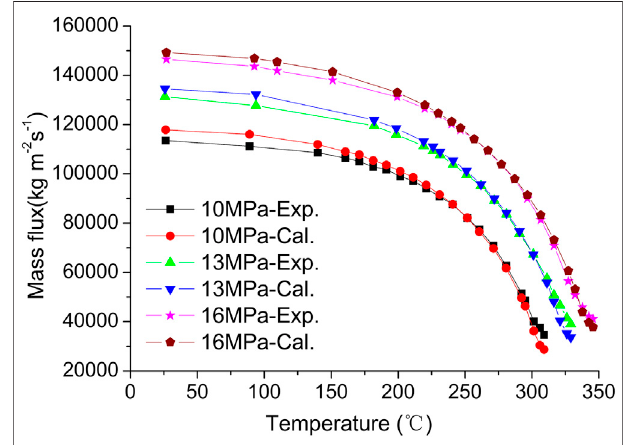
FIGURE 6 | Comparison of model prediction with experiment data (subcooled condition).